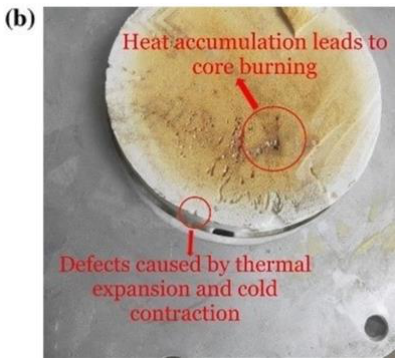
Figure 1. Thermal expansion and core burning of filling material in composite cross-arms ( a ) Cracking of a cross-arm sample; ( b ) Core burning of a cross-arm sample.